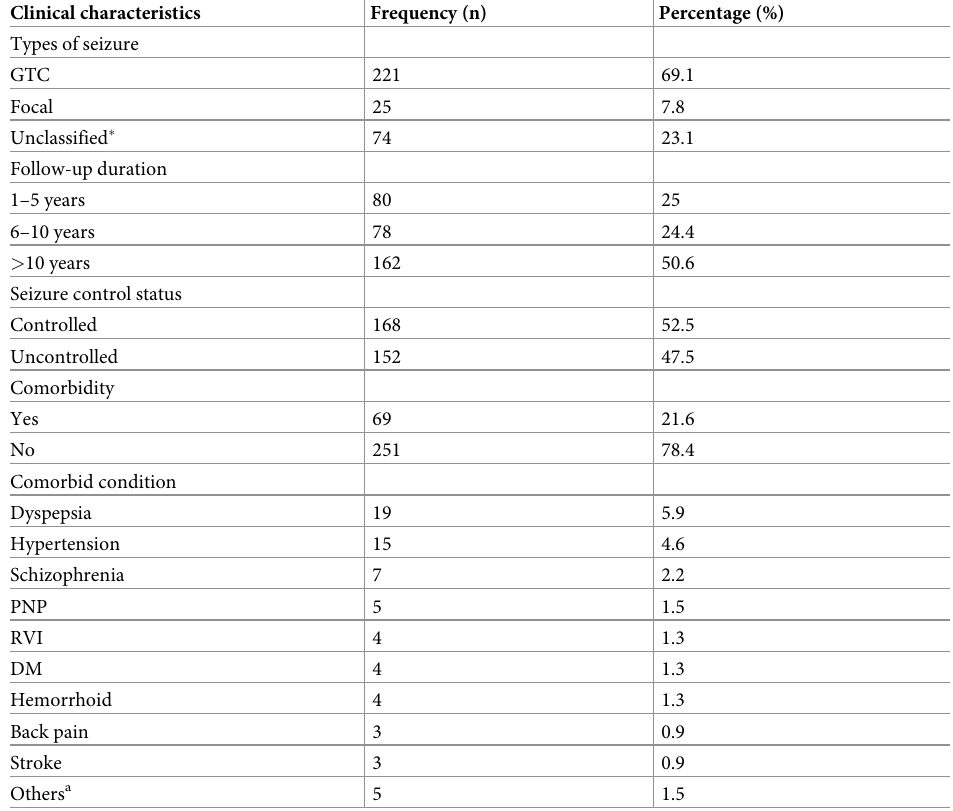
Table 2. Clinical characteristics of epileptic patients attending ambulatory clinic of JMC, 2021. Clinical